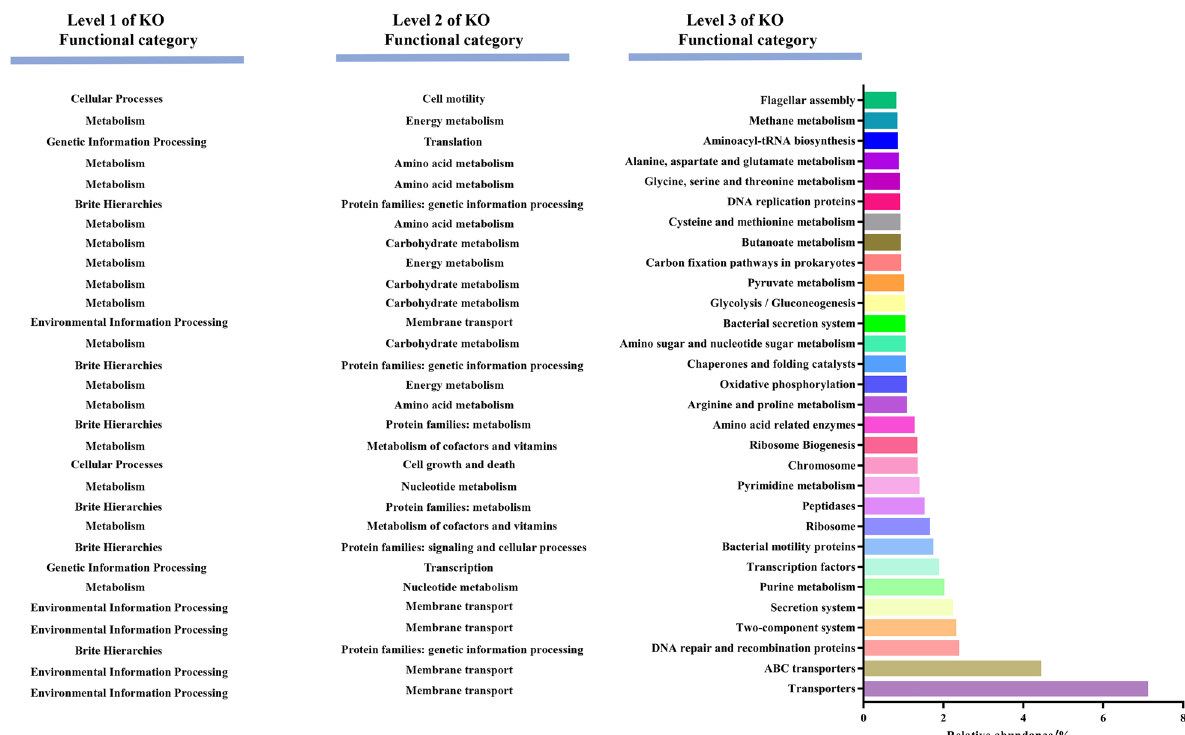
Fig. 4 Relative abundance of the top 30 KEGG Orthology (KO) in all developmental stages of A.